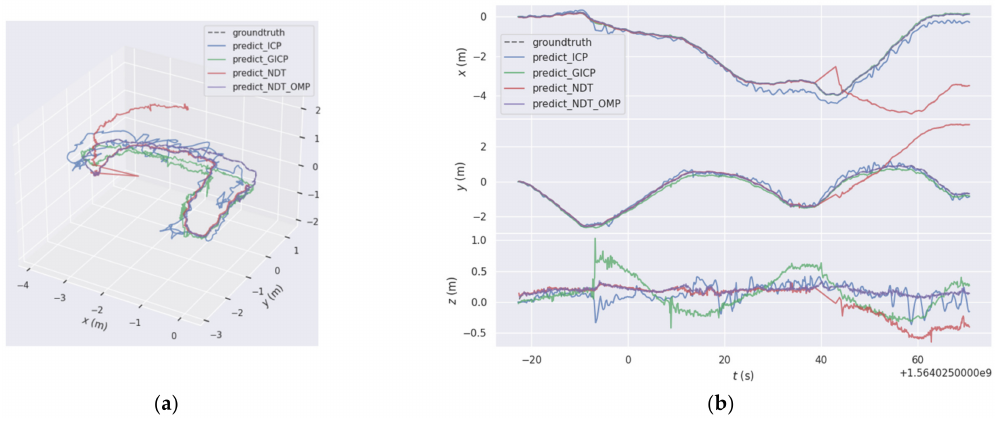
Figure 12. ( a ) Three-dimensional trajectory diagram and ( b ) XYZ coordinate data.